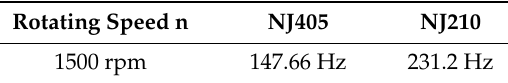
Figure 14. Time-domain and frequency-domain graphs of experimentally acquired signals. ( a ) Time domain. ( b ) Frequency domain. Table 1. Failure frequency.